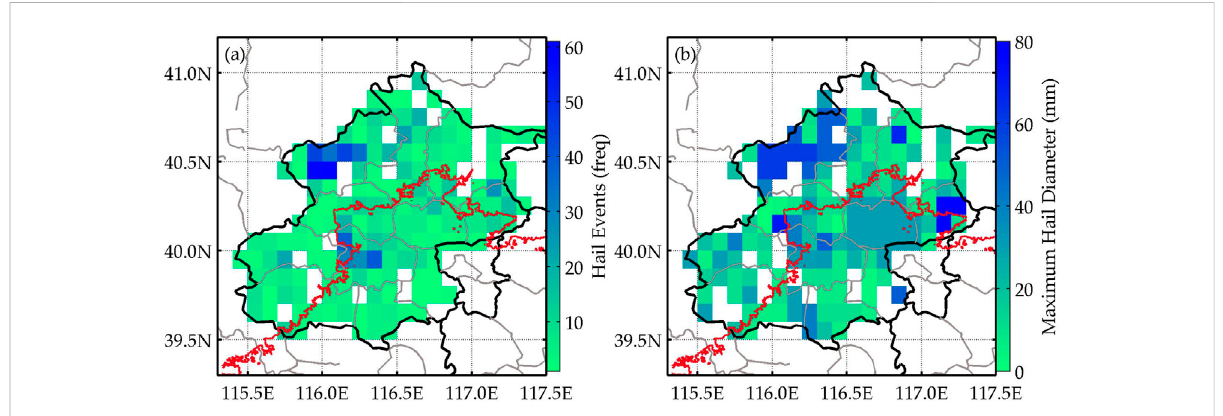
FIGURE 5 Spatial distributions of hail characteristics in Beijing from 1980 to 2021: (A) . Gridded hail events data; (B) . Maximum hail diameter of each grid. The red line shows the contour of 100 m elevation.